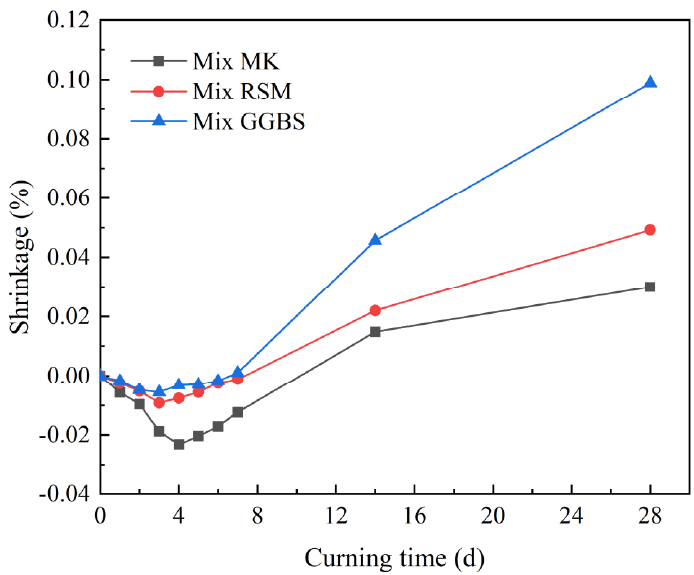
Figure 20. Shrinkage of geopolymer mortars.